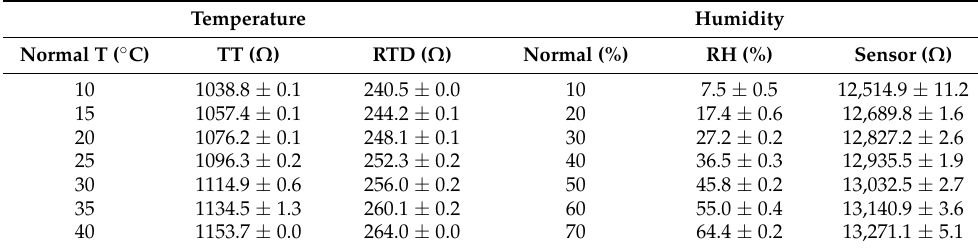
Table 4. Comparison of temperature and humidity